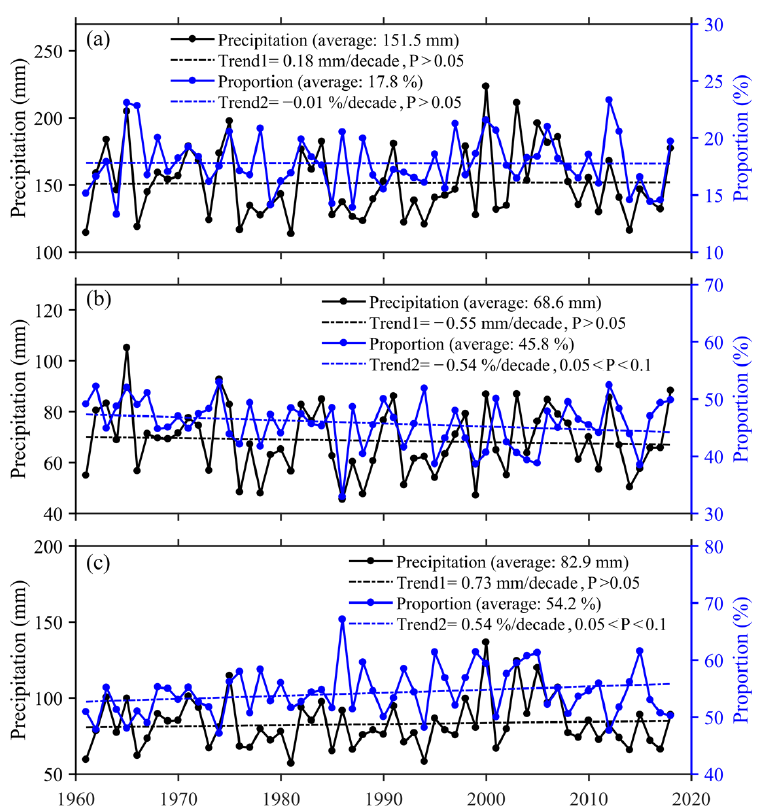
Figure 10. ( a ) Annual variations in RX5day precipitation and its proportion to the annual total precipitation. The amount and proportions of ( b ) daytime and ( c ) nighttime precipitation under RX5day